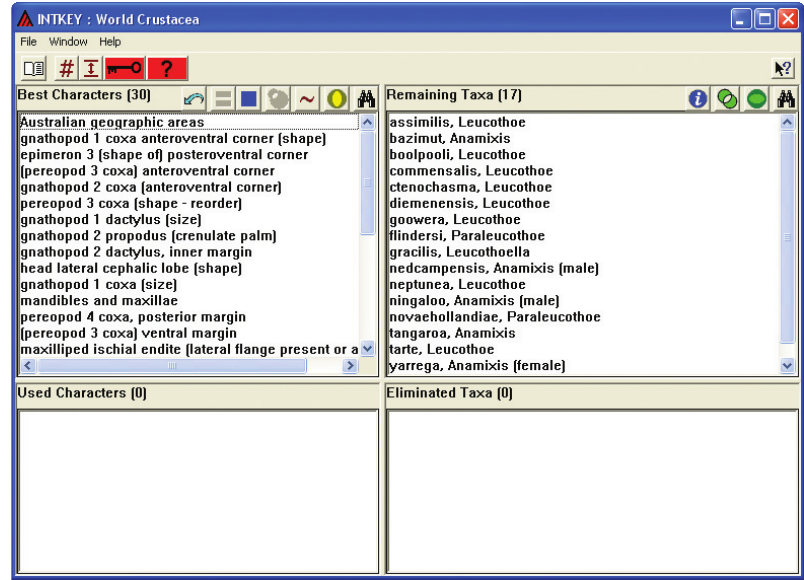
Figure 36. Sample fi le of Australian leucothoid amphipods in